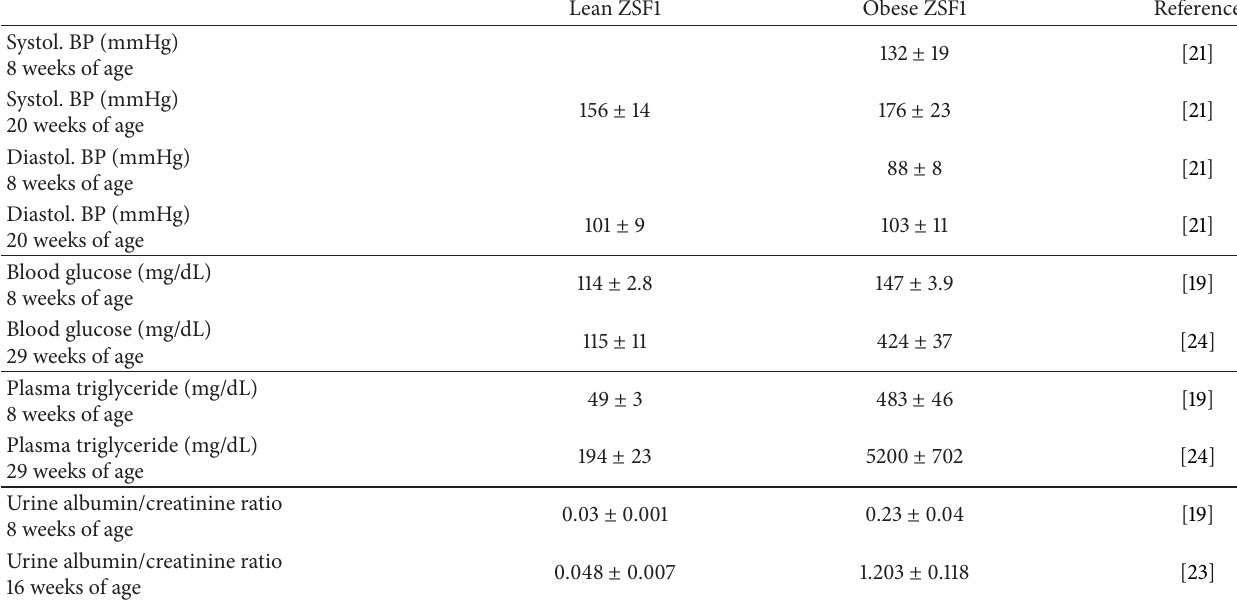
Table 1: Blood pressure (BP), blood glucose, plasma glyceride, and urine albumin/creatinine ration in young and old male ZSF1